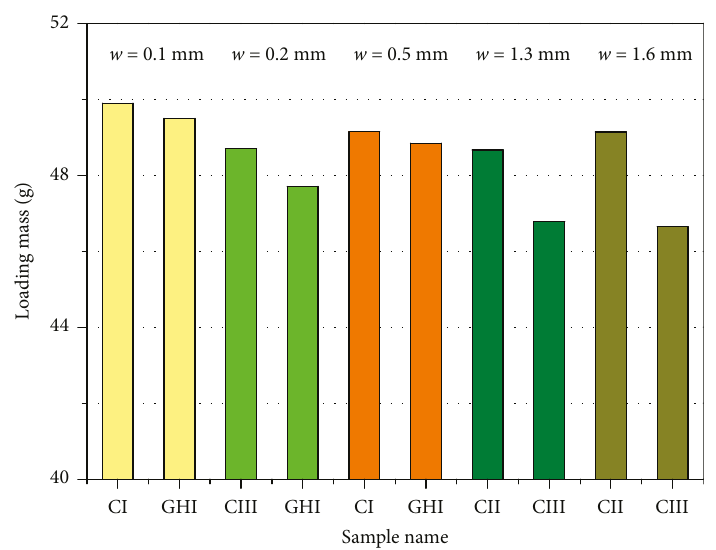
Figure 11: Loading mass at di ff erent roughness.